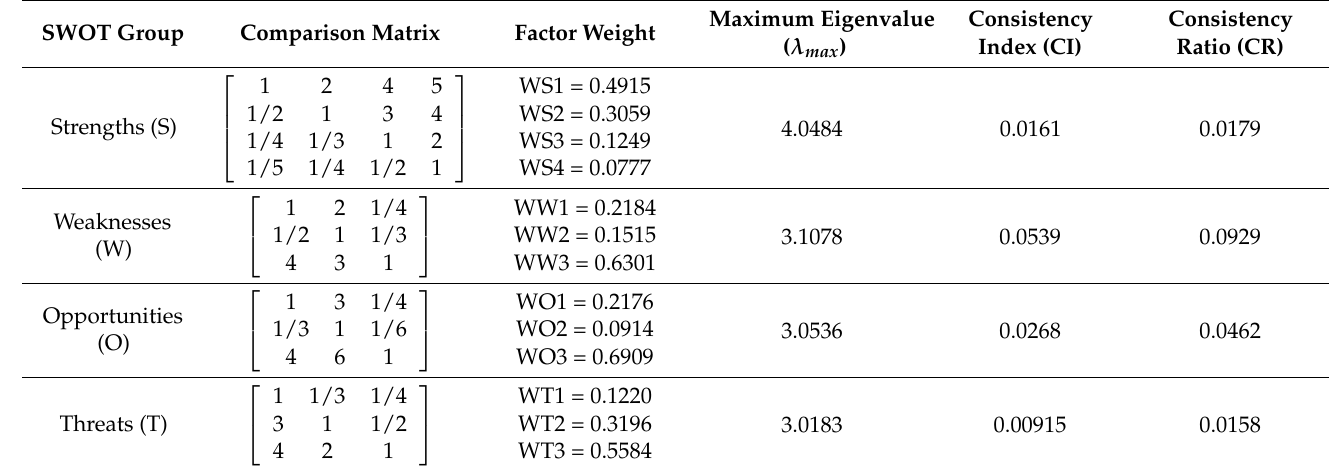
Table 4. Comparison matrix and weights of SWOT groups and factors.